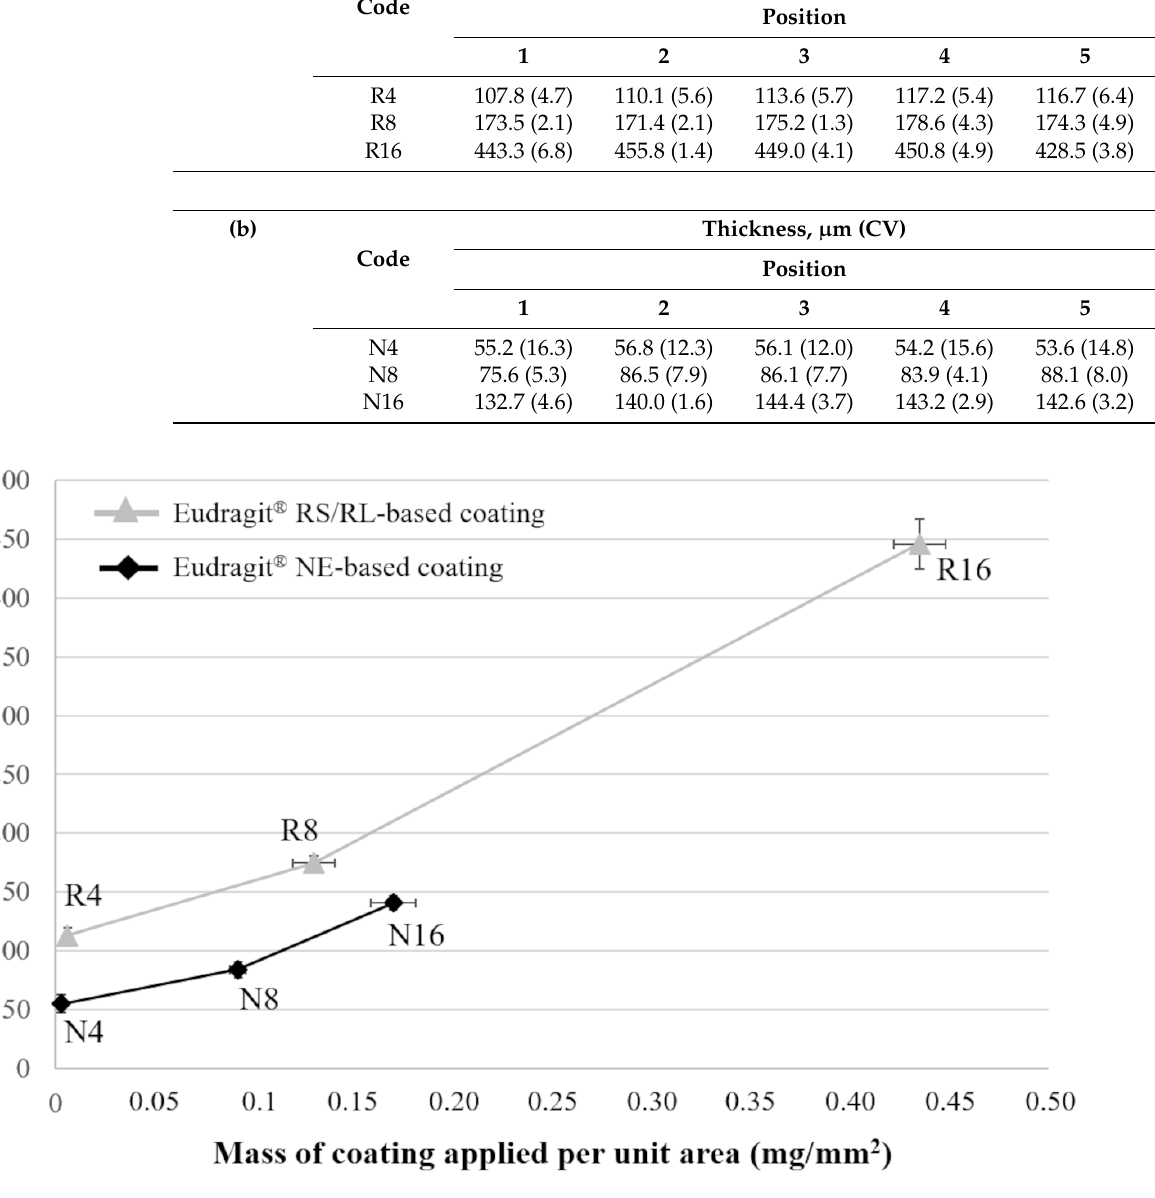
Figure 4. Coating thickness versus amount of coating applied to I-shaped samples.